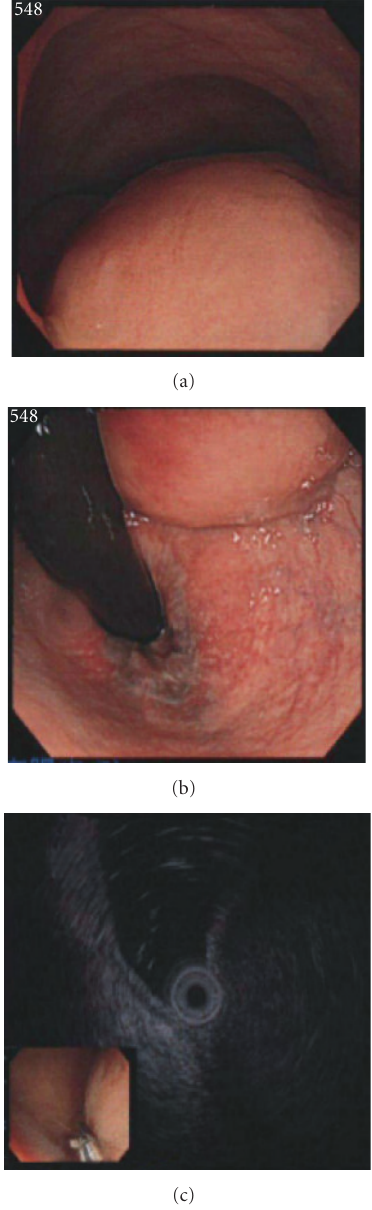
Figure 2: Endoscopic (a, b) and EUS (c)